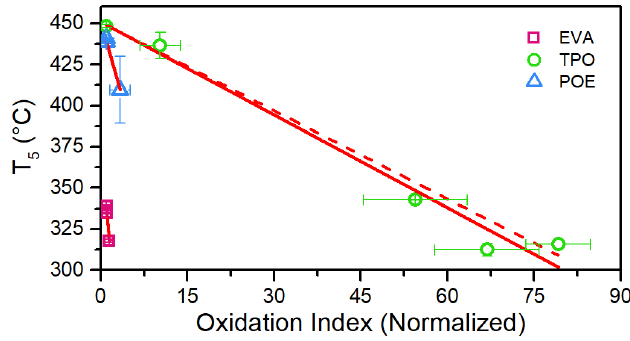
Figure 16. T 5 values vs. Normalized Oxidation Index. Solid lines correspond to the linear fitting applied to the datasets for EVA and POE. For TPO, the solid line corresponds to the fitting applied to the whole dataset, whereas the dashed line corresponds to the fitting applied to four points over five.